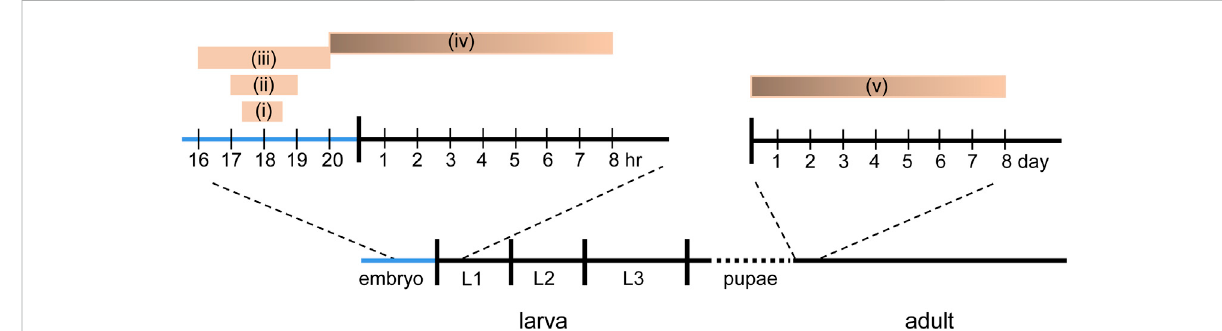
Known CPs in Drosophila . Five different, but in some cases, overlapping CPs have been reported in Drosophila . (i) Manipulation of activity between 17.5 and 18.5 h after egg laying (AEL) is suf fi cient to delay the development of the locomotor circuit to support hatching (Crisp et al., 2011). (ii)Manipulationofactivitybetween17 – 19 hAELissuf fi cienttoinduceaseizurephenotypeinlarvae(GiachelloandBaines,2015).(iii)Manipulationof sensory input, via chordotonal neurons, between 16 – 20 h AEL is suf fi cient to reduce crawling speed in larva (Fushiki et al., 2013). (iv) Activity manipulation, in the last hr of embryogenesis through, with weakening in fl uence, to 8 h after hatching, is suf fi cient to alter motoneuron dendritic growth (Ackerman et al., 2021). (v) Exposure to odor is suf fi cient to alter synaptic connectivity in the olfactory system within the fi rst 2 days after eclosion (Golovin and Broadie, 2016; Golovin et al.,